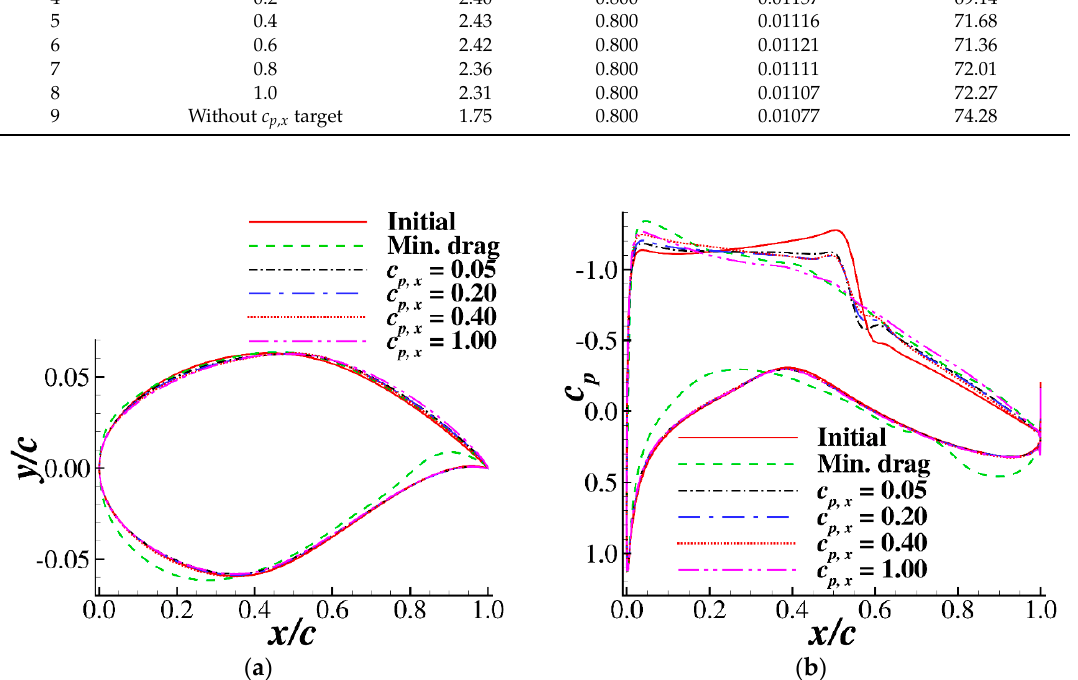
Figure 13. Geometries and pressure distributions of the airfoils ( Ma = 0.73, Re = 6.5 × 10 6 , C L = 0.800). ( a ) Airfoil geometries; ( b ) pressure distributions.